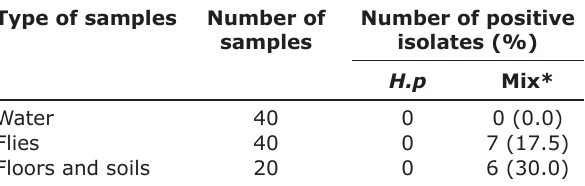
Table-3: Occurrence of H. pullorum in water, flies, and floor and soil. Type of